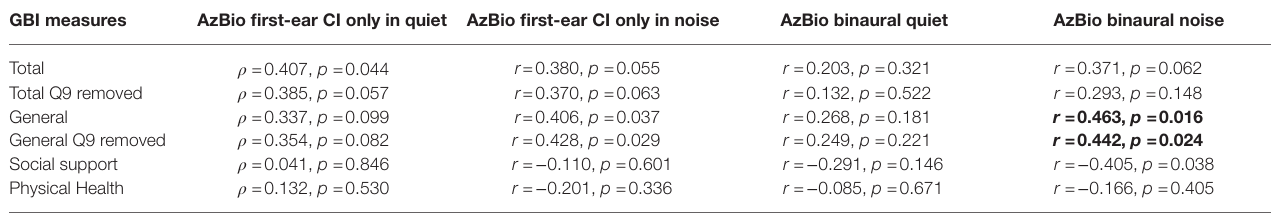
TABLE 3 | Relationships between AzBio and GBI scores.